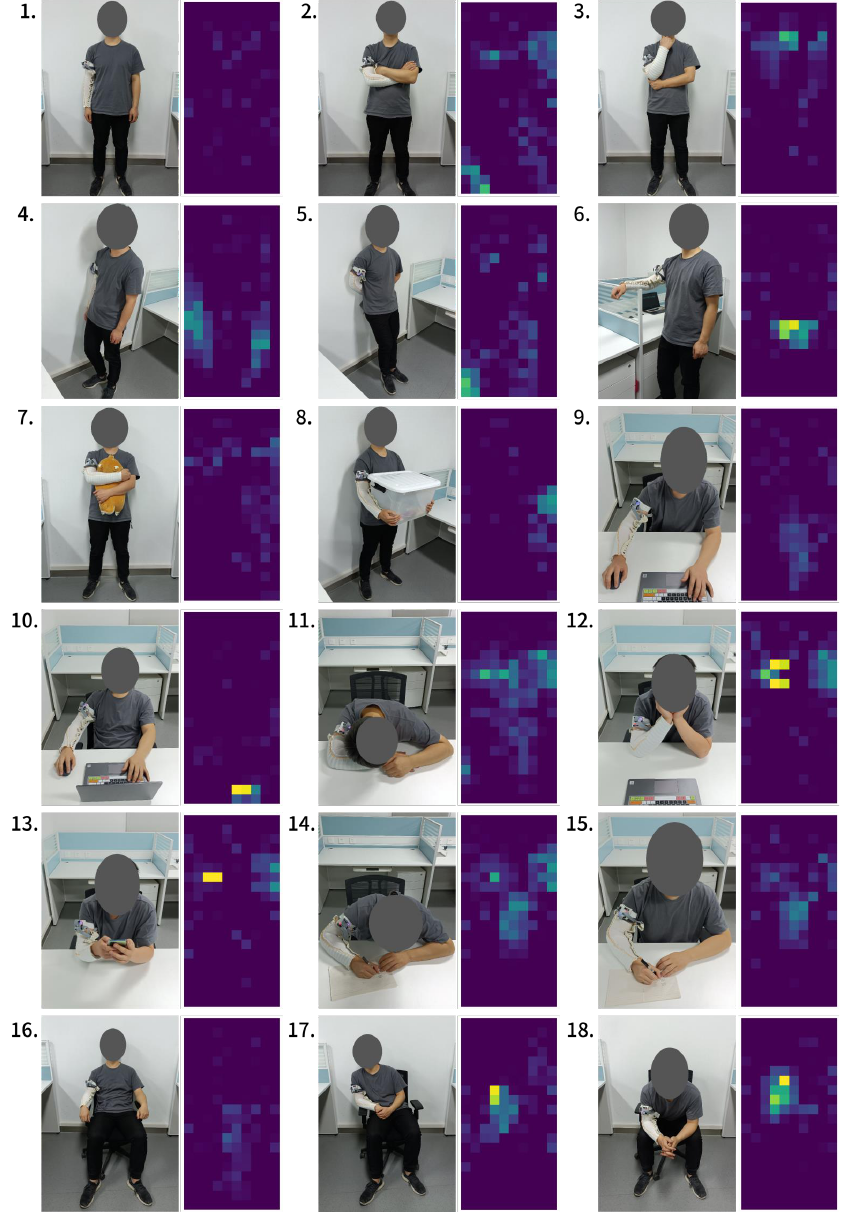
Figure 2. Eighteen activities and the corresponding pressure distribution on the Smart-Sleeve.